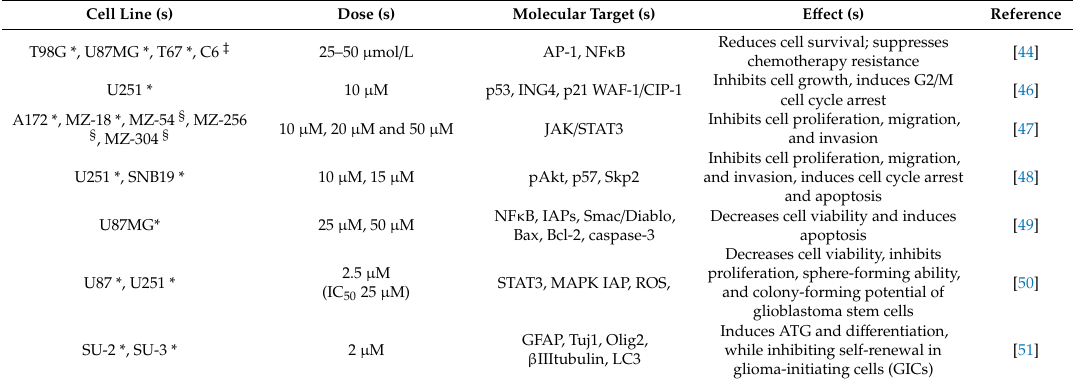
Table 1. In vitro anti-tumor e ff ects of curcumin on glioblastoma